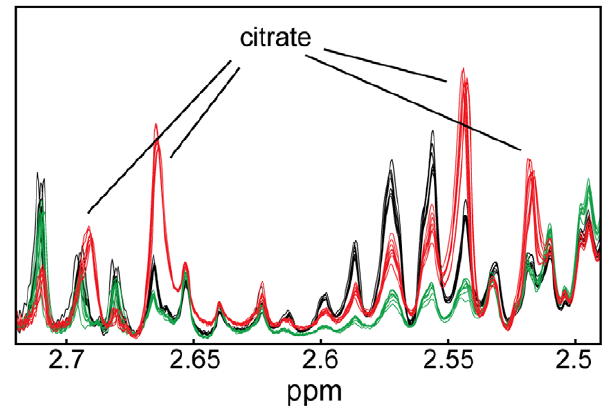
Figure 5. Accumulation of citrate following treatment with 17AAG in PC3 prostate cancer cells. Enlarged section (2.49 – 2.72 ppm) of the MR spectra acquired on polar extracts of PC3 cells following 48 hours of treatment with DMSO (solvent control, black), LY294002 (green) and 17AAG (red). Spectra were normalized according to the probabilistic quotient normalization method.